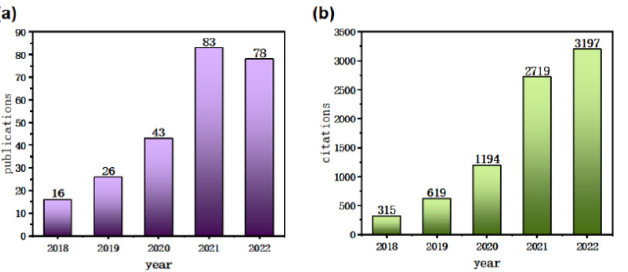
Figure 1. Number of ( a ) publications and ( b ) citations obtained from a survey performed in the Web of Science using “MIL” AND “Fenton” as keywords (data from 2018 to 2022).